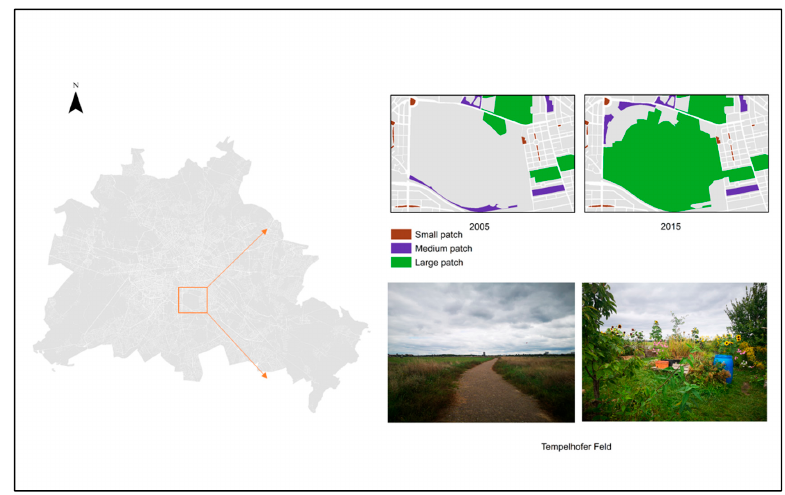
Figure 4. Tempelhof Park converted from a brownfield.